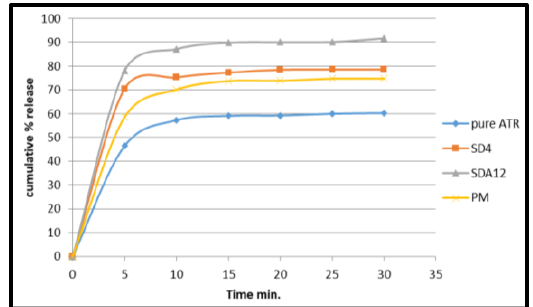
Figure 3.Comparative in-vitro dissolution profile of the ATR, SDA12, SD4 and physical mixture of SDA12(PM) at phosphate buffer 6.8 and 37°C±0.5 X-ray powder diffraction (XRD)